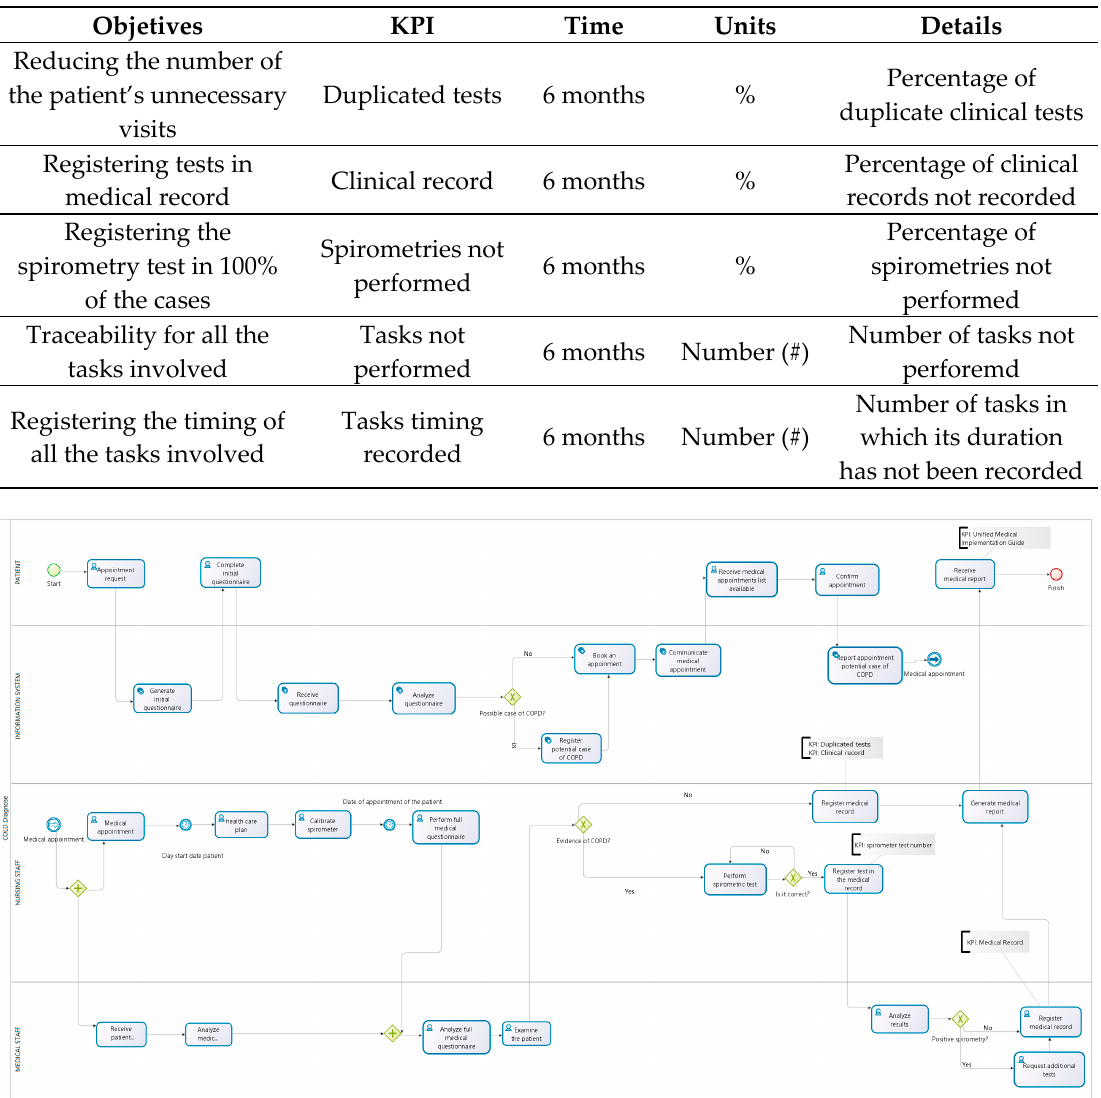
Table 1. KPIs for the redesign stage.